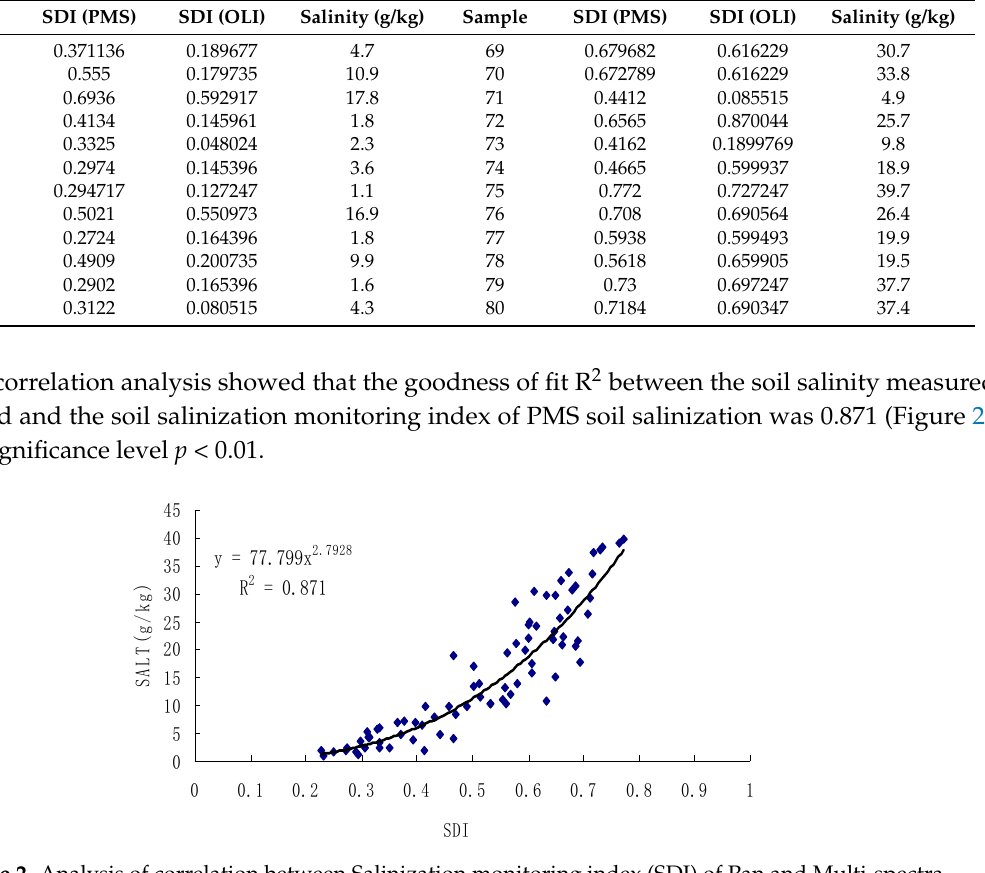
Figure 2. Analysis of correlation between Salinization monitoring index (SDI) of Pan and Multi-spectra Sensor (PMS) image and measured salt content.